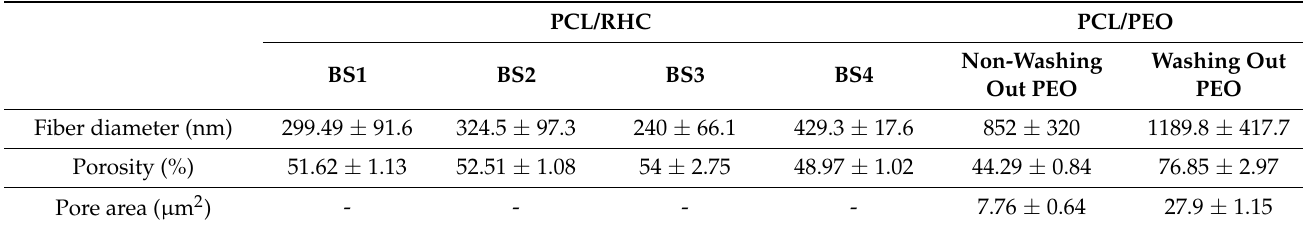
Table 2. Mean and standard deviation values of the mechanical parameters obtained by axial and